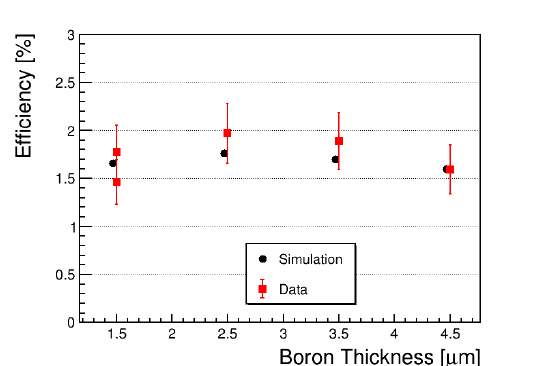
Fig. 6. Neutron detection efficiency of a µRWELL detector with planar boron-coated cathode as a function of the boron thickness is shown.